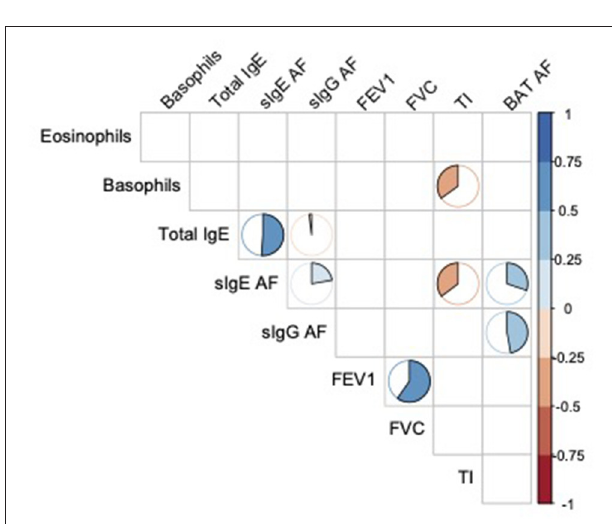
FIGURE 4 | Spearman’s correlation matrix of eosinophils and basophils count, total IgE, specific IgE and IgG AF levels, pulmonary function tests results and functional cellular assays. Only significant correlations (a = 0,05) are illustrated by a pie chart. The fill rate of pie chart is proportional to correlation coefficient. AF, Aspergillus fumigatus; FEV1, Forced expiratory volume in 1 sec; FVC, forced vital capacity; TI, Tiffeneau index.